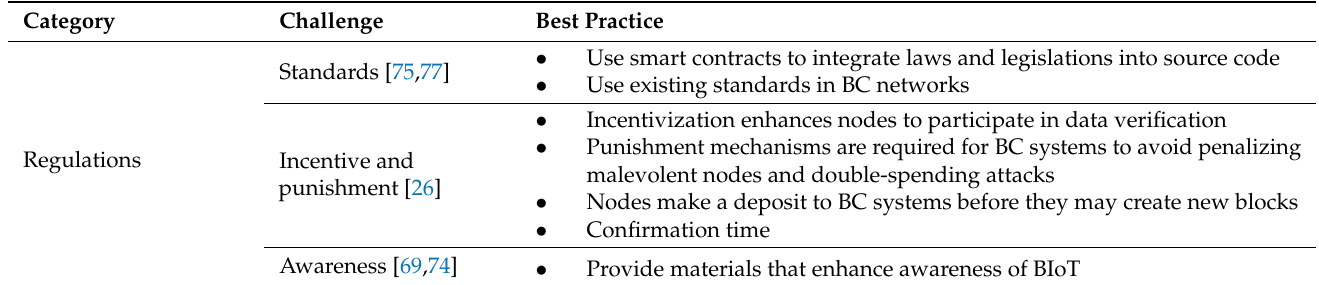
Table 11 highlights the best practices for addressing guidelines and governance challenges. Table 11. Recommendations for reducing the negative impact of regulations